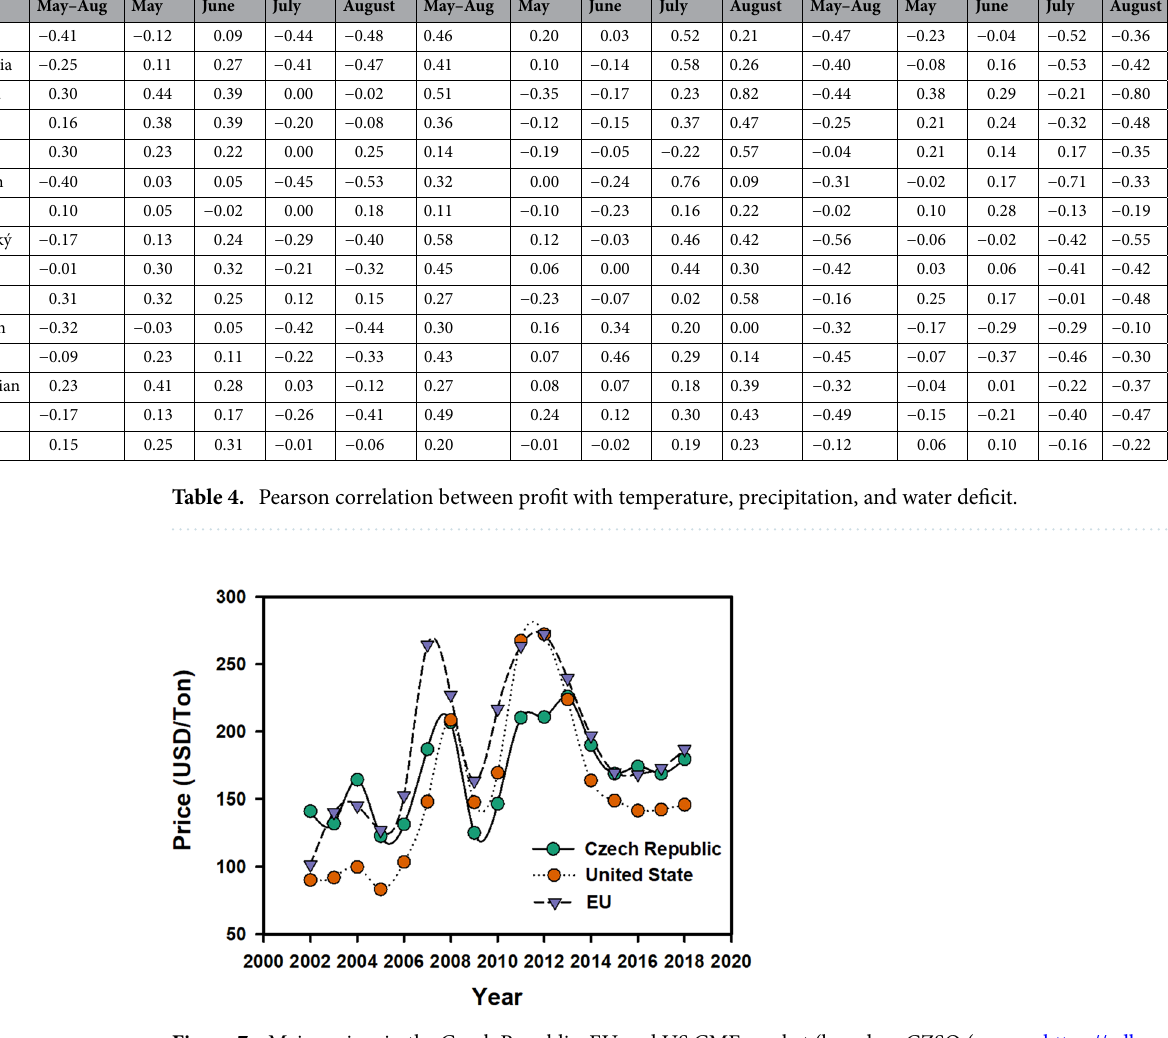
Figure 7. Maize prices in the Czech Republic, EU and US CME market (based on CZSO ( source : https:// vdb. czso. cz/ vdbvo2/ faces/ en/ index. jsf? page= vystup- objek t&z= T&f= TABUL KA& katal og= 31785 & pvo= CEN02